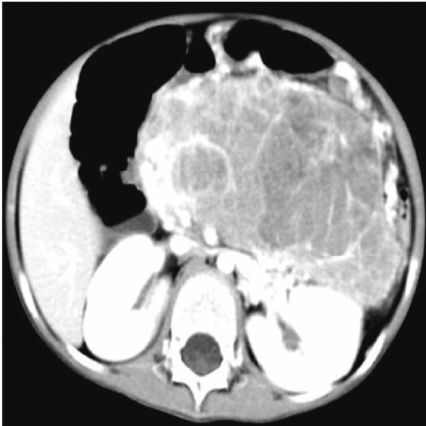
Figure 4: Contrast-enhanced CT revealed the heterogeneous mass with obvious enhancement areas and scattered low attenuation.